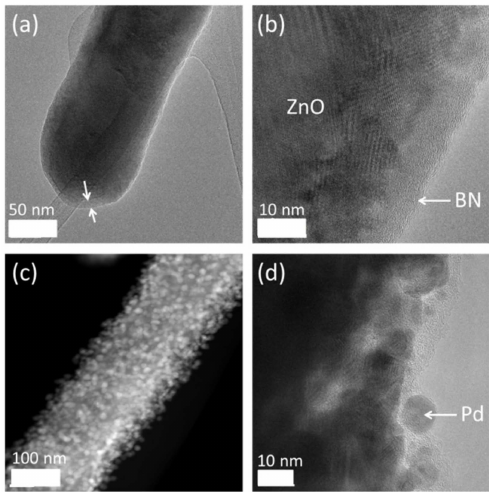
Figure 12. TEM images of ( a , b ) the BN / ZnO NWs and ( c , d ) the Pd NPs / BN / ZnO NWs. In ( a ) and ( b ), the BN layer is shown by arrows. In ( d ), a Pd NP is designated. Reproduced from [39] with permission from The Royal Society of Chemistry,